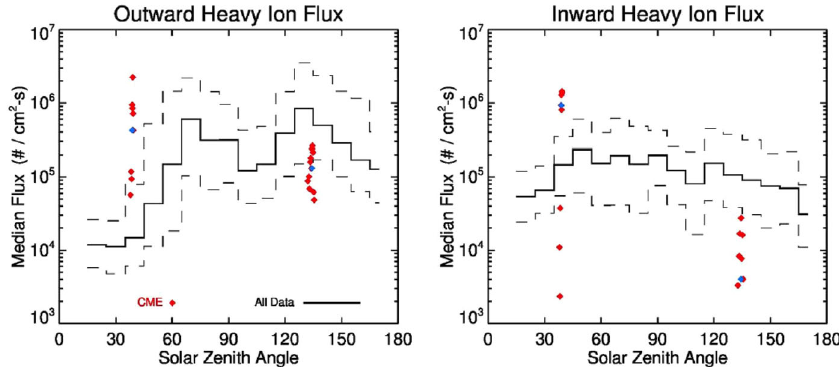
Fig. 36 Atmospheric loss at Mars during encounters with ICMEs (red diamonds, blue show the median) compared to integrated loss through the mission duration (solid: median, dashed: first/fourth quartiles) as a function of solar zenith angle. Image reproduced by permission from Jakosky et al. (2015), copyright by